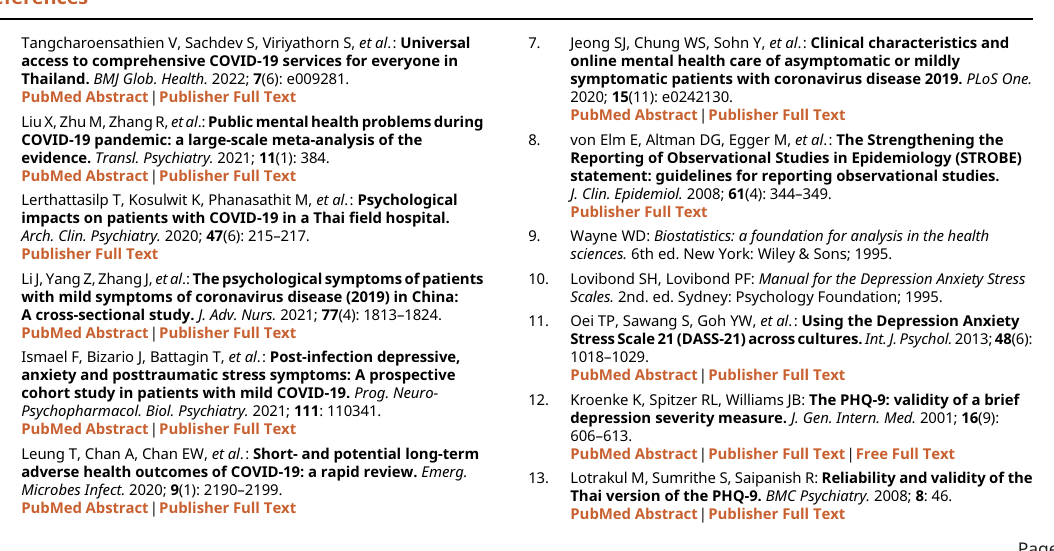
figshare: Mental health problems of asymptomatic or mildly symptomatic COVID-19 patients in hospitel in Thailand: A Cross-Sectional Study, https://doi.org/10.6084/m9.figshare.21108790.v1. 19 This project contains the following extended data: